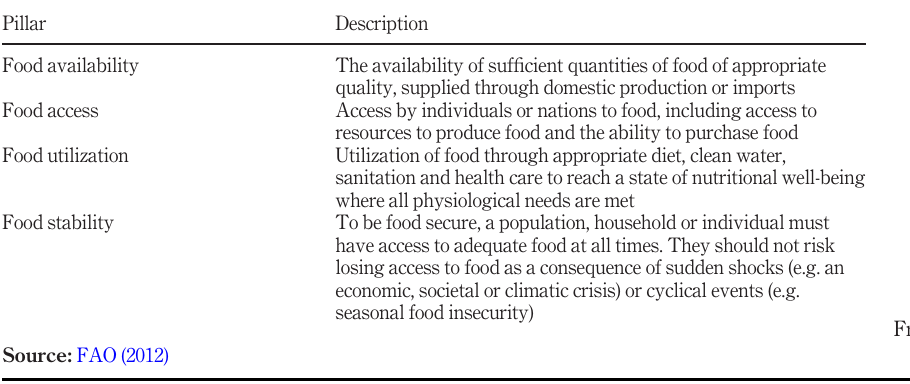
Table 1. Framework for food security